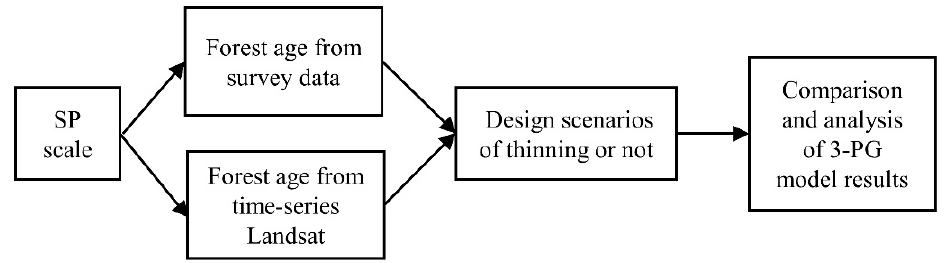
Figure 4. Simulation scheme design at the sample plot level.